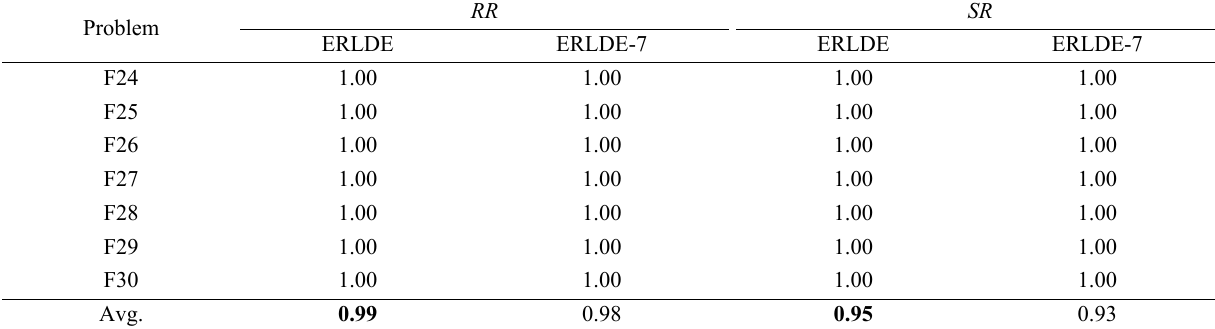
Table A6 Comparison between ERLDE and ERLDE-7 with respect to RR and SR .